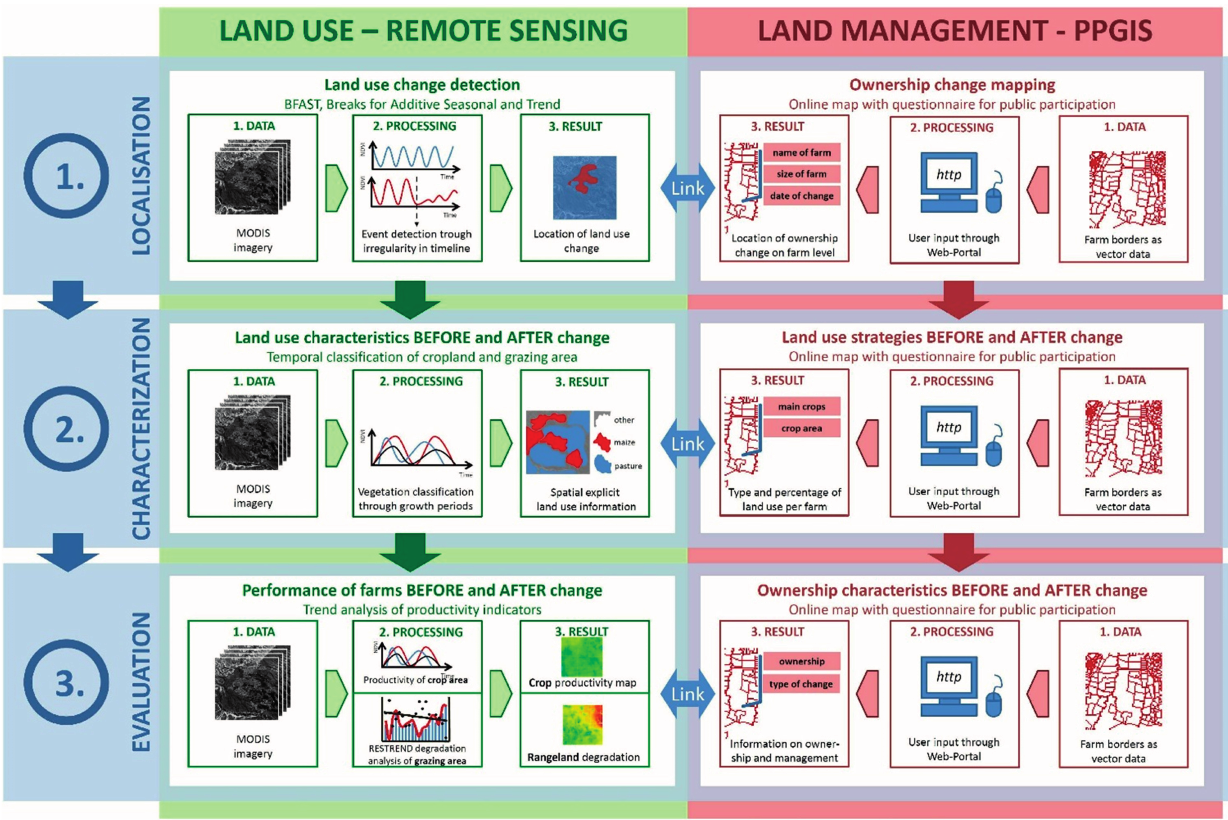
Figure 3. Research framework: linking land use change and ownership change by means of remote sensing and public participatory geographic information system